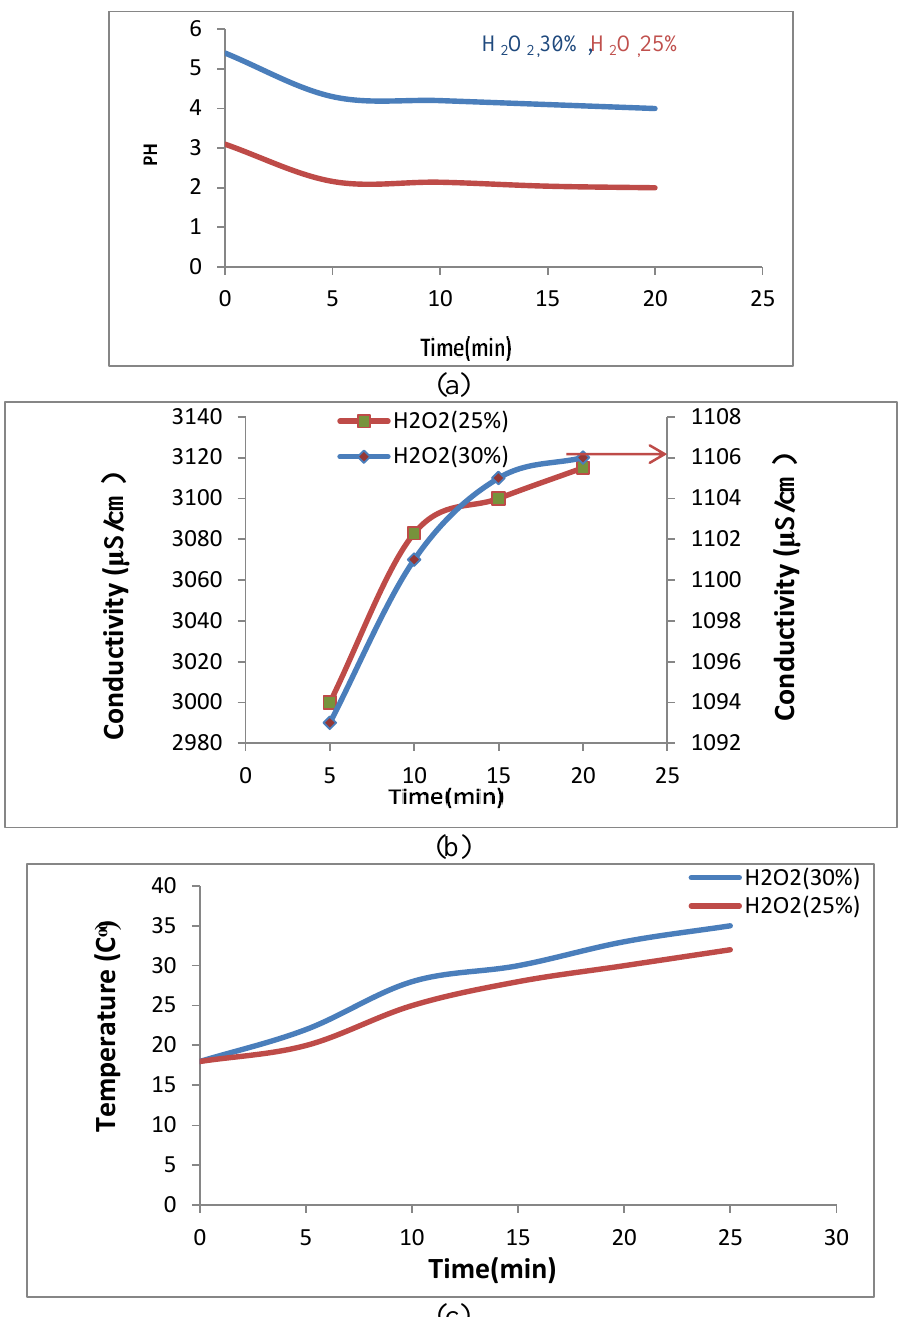
Fiq.5: (a) pH variation of with the exposer time (b) conductivity variation for hydrogen peroxide (25%, 30%) concentration, with the exposure time (c) temperature variation with the exposure time for hydrogen peroxide (25%, 30%)